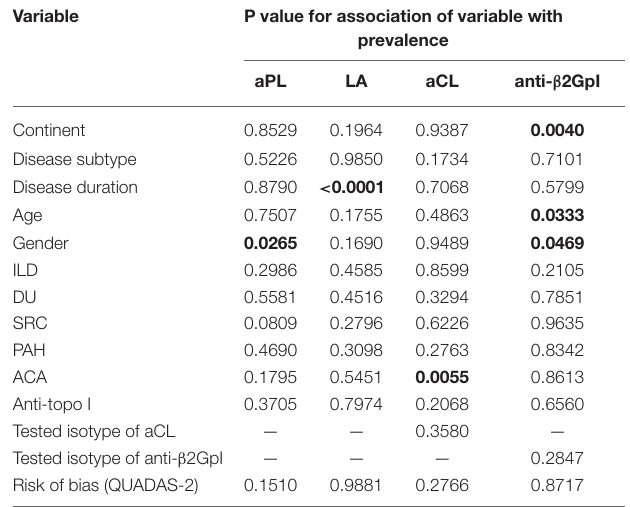
Frontiers in Immunology |